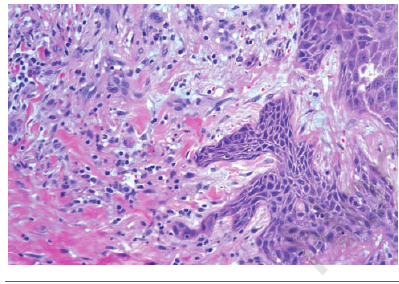
Figure 2. Histopathology of the skin lesion revealing infiltrating atypical squamous cells into the deeper stromal tissue (H&E stain).